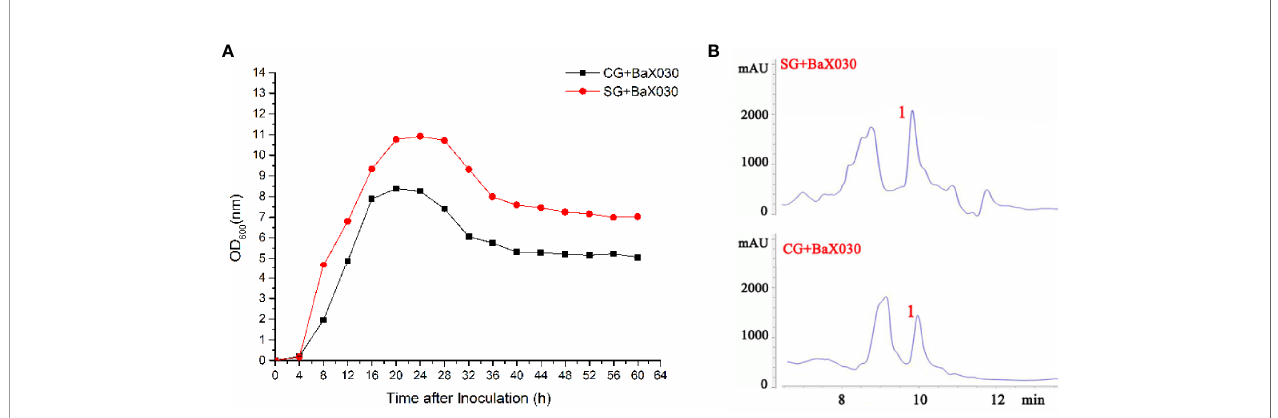
FIGURE 1 | Growth parameters and separation and puri fi cation of BaX030. (A) The growth curve of CG+BaX030 and SG+BaX030. Datas were mean ± SEM for n=3 biologically independent experiments; (B) HPLC chromatograms of BaX030 in different